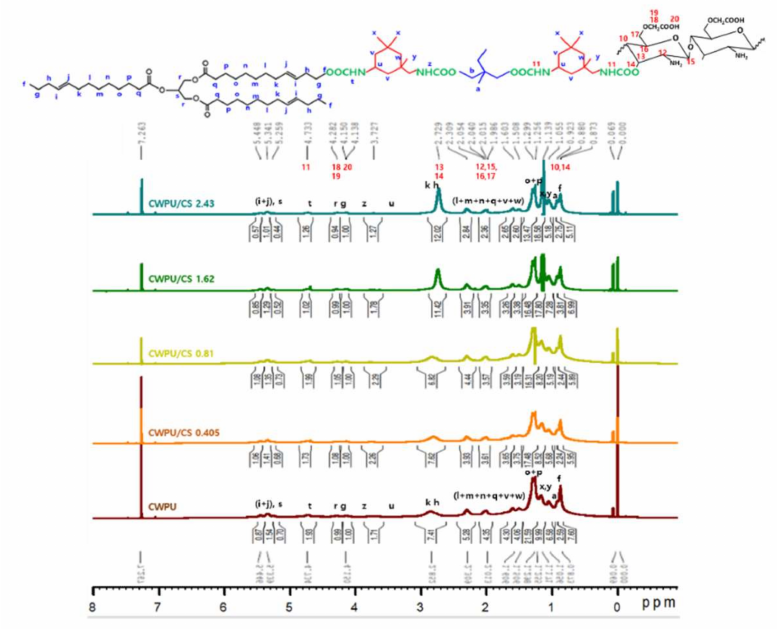
Figure 1. 1 H-NMR spectra of CWPU and CWPU/CS nanocomposites with various CS contents.